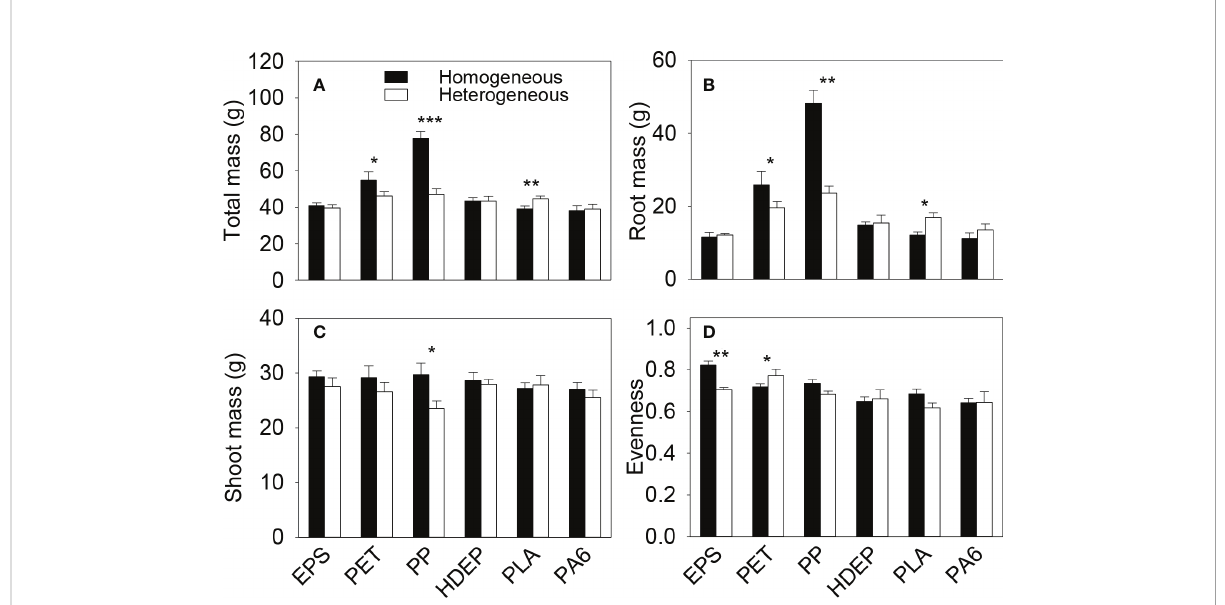
FIGURE 2 (A) Total, (B) root and (C) shoot biomass and (D) species evenness of the plant communities in the homogeneous and the heterogeneous treatment for each of the six types of microplastics. Bars and vertical lines are mean and SE. Symbols (*** P < 0.001, ** P < 0.01 and * P < 0.05) indicate signi fi cant differences between the homogeneous and the heterogeneous treatment.